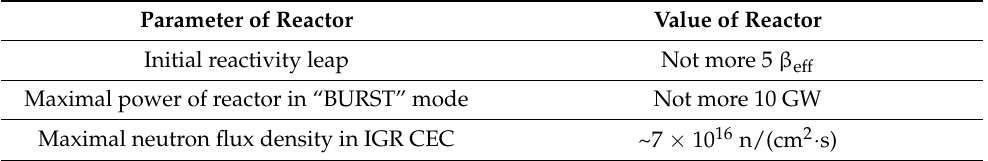
Table 1. Calculated values of IGR Reactor Operation Mode during Experiments in “Burst” Mode. Parameter of